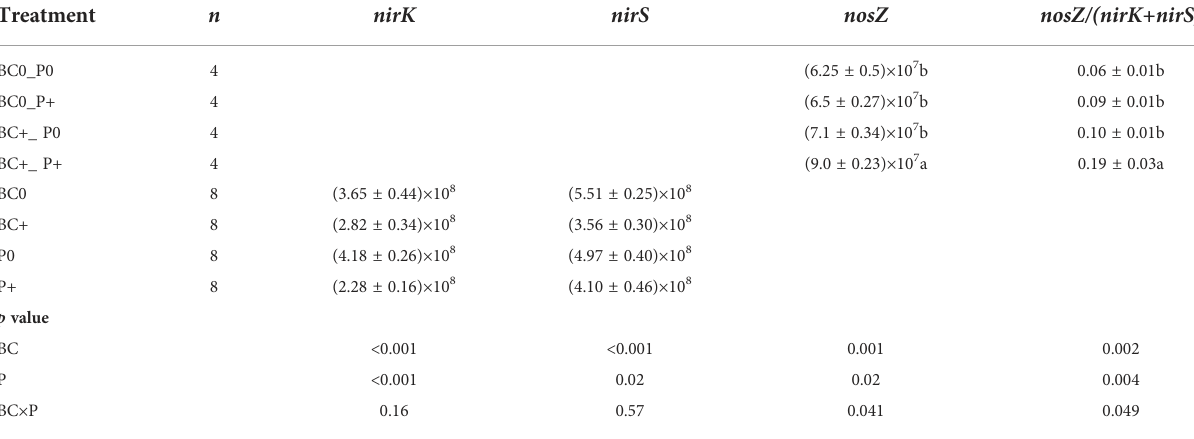
TABLE 2 Effects of P and biochar application on N 2 O emission, nirK, nirS and nosZ gene copy numbers and nosZ/(nirK+nirS) in fi eld experiment.